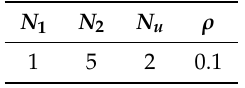
Table 6. Parameters of the model-based predictive controller for the Yeast Fermentation Reactor Temperature